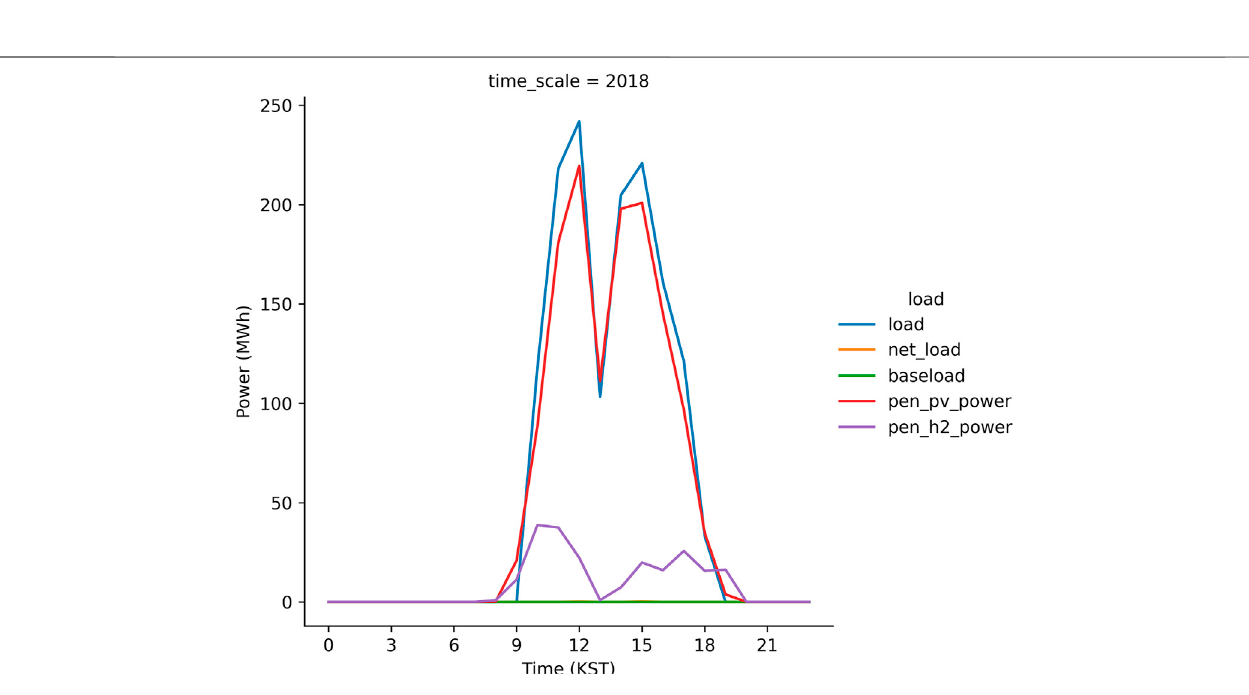
Frontiers in Chemistry |